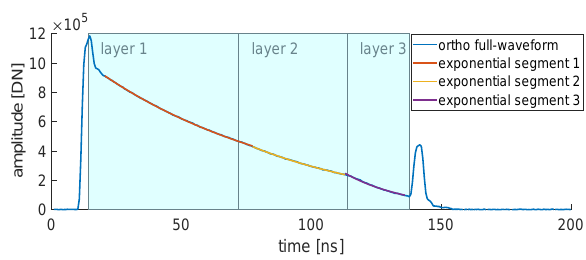
Figure 8. Segmentwise exponential function approximation for a simulated ortho full-waveform.